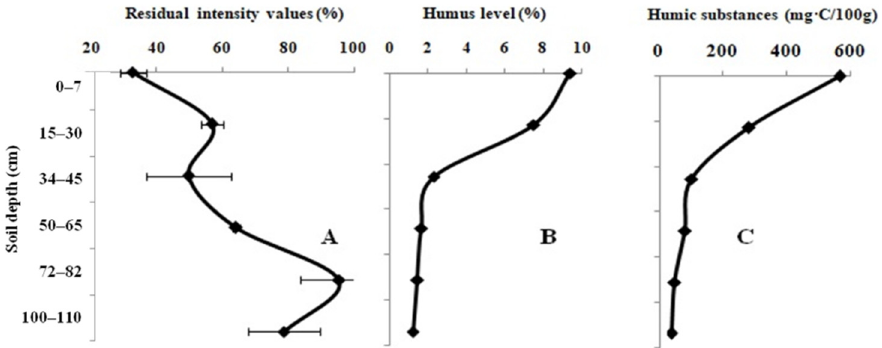
Figure 2. Variation in the residual light intensity of the Red + Luc enzyme system ( A ); humic ( B ) and labile humic substances ( C ) in the full-profile of the 10-year fallow-land samples.